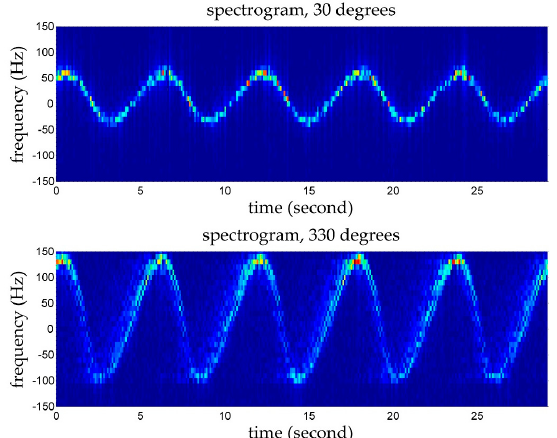
Figure 14. Extracted Doppler shift frequency and its amplitude spectrum. A harmonic of wave frequency can be found at the frequency 0.3412 Hz.